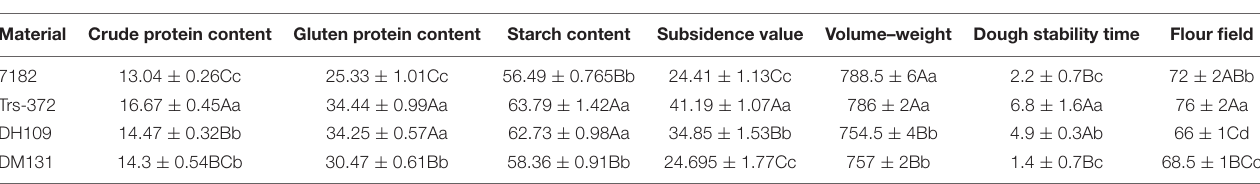
TABLE 5 | Grain quality results of DH109, DM131, and their wheat parents.